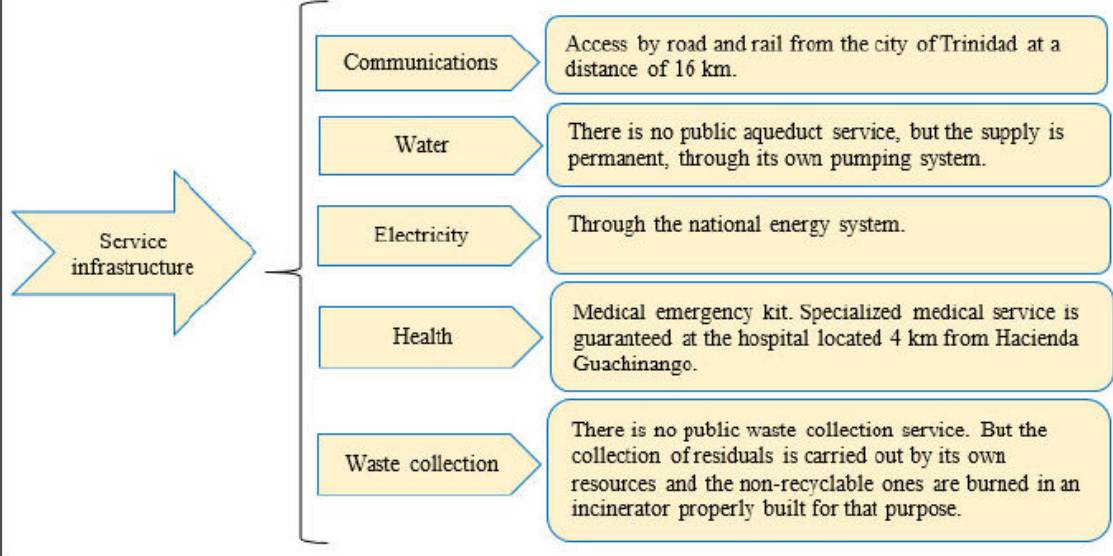
Figure 6. Infrastructure of basic services available for agrotourism in Hacienda Guachinango. Source: own elaboration based on the results of the inventory of resources in Hacienda Guachinango.